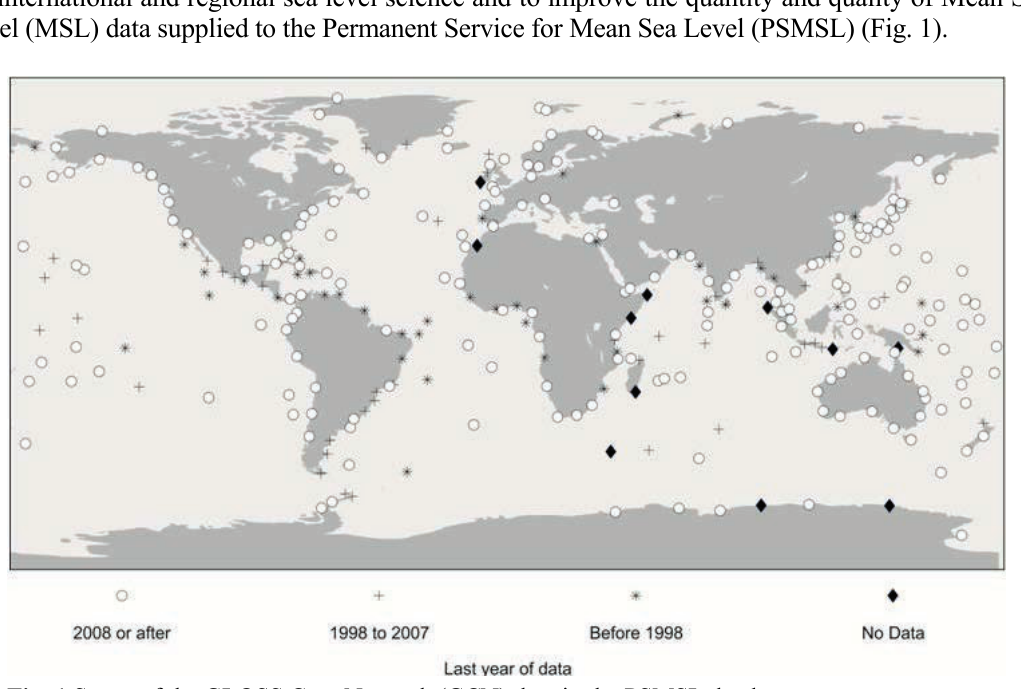
Fig. 1 Status of the GLOSS Core Network (GCN) data in the PSMSL